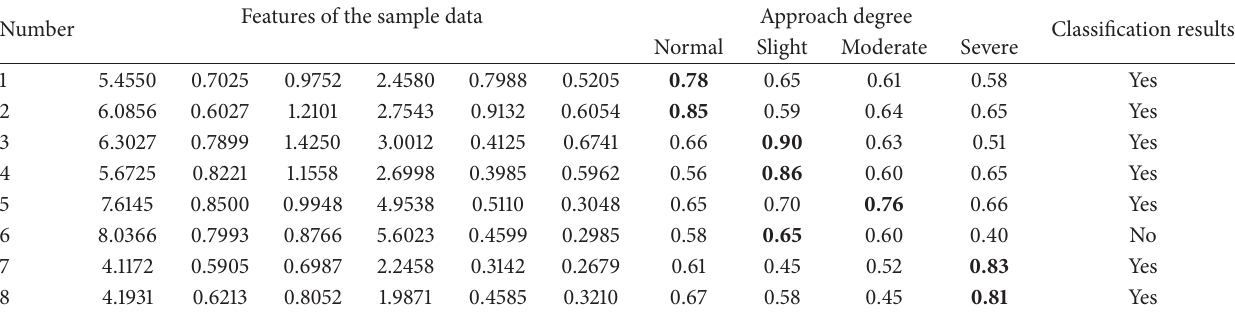
Table 2: Diagnosis results in nonentire work cycle